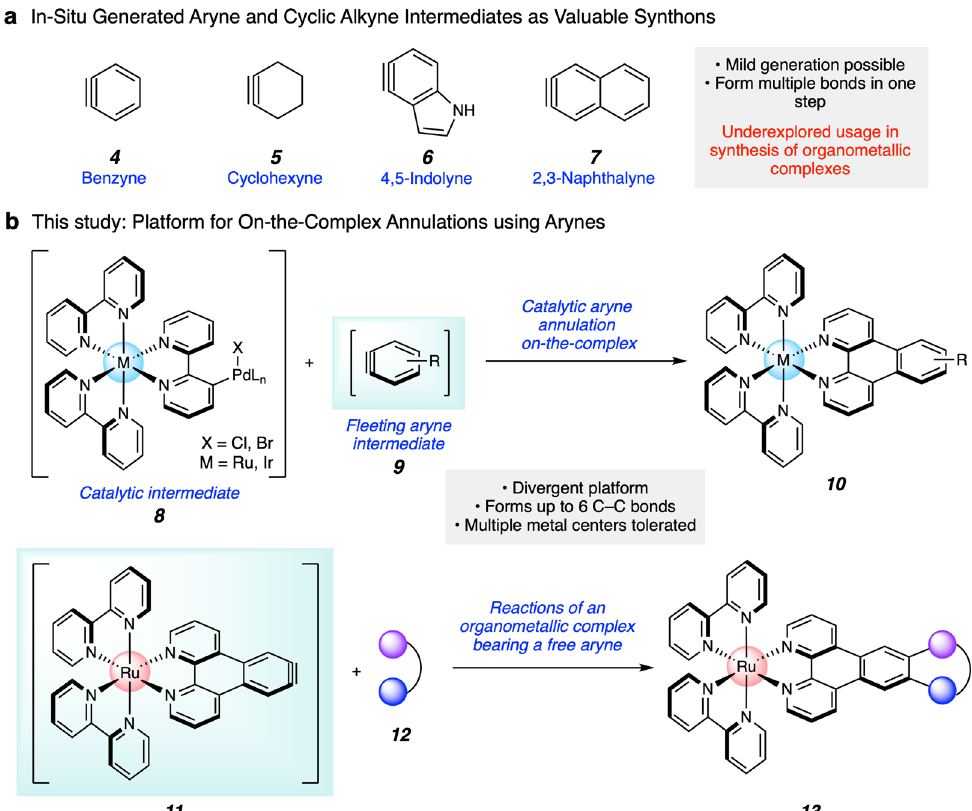
Fig. 2 Arynes-on-the-complex approach to metal complexes. a Aryne and cyclic alkyne intermediates. b Our approach to the direct manipulation of polypyridyl metal complexes using